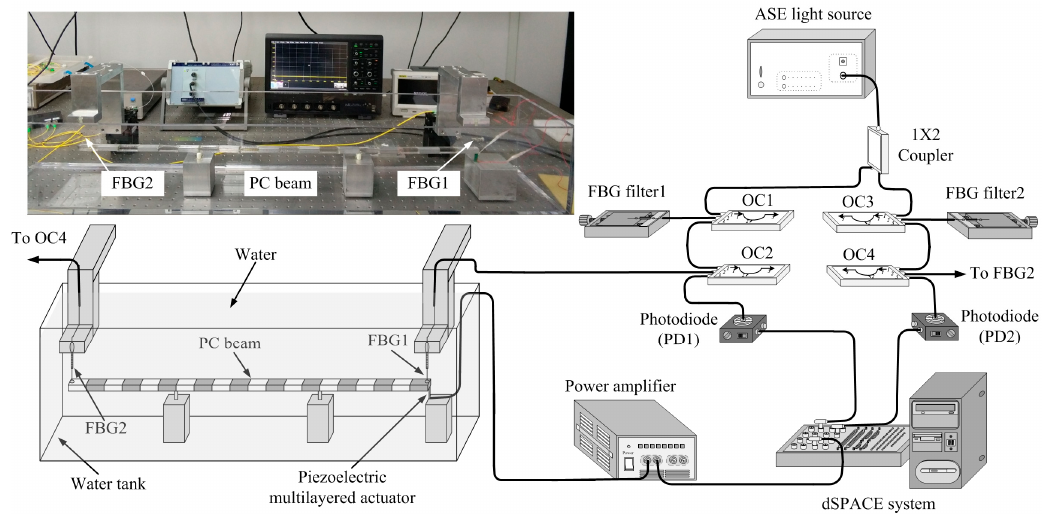
Figure 3. Experimental setup of the submerged PC beam and the fiber Bragg grating (FBG) displacement sensing system (color online).